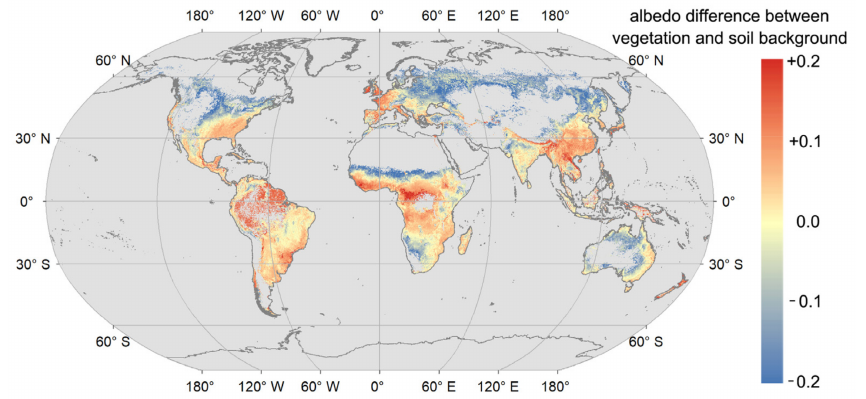
Figure 7. Spatial distribution of the albedo differences between the vegetation and soil background. The pixels with no data are colored